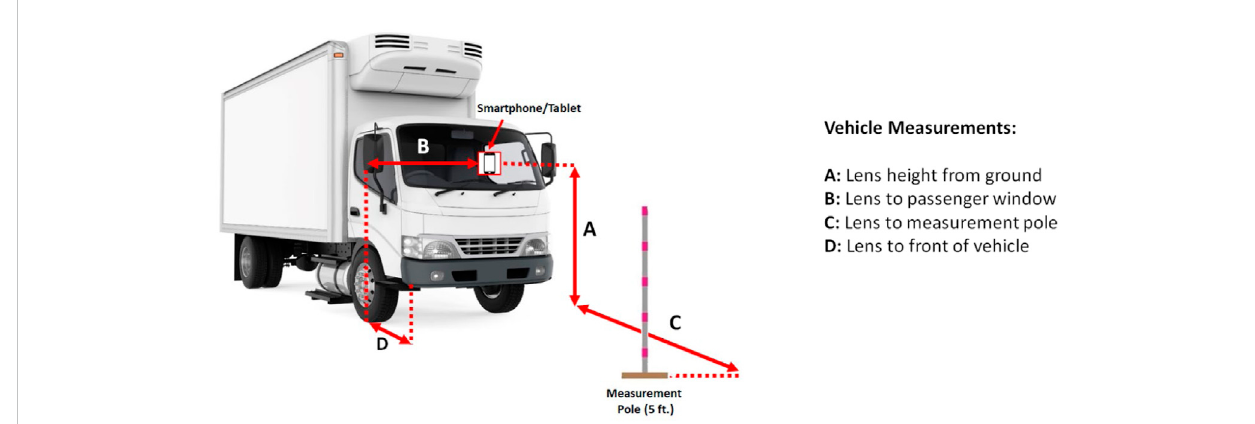
FIGURE 2 VIEWappmeasurement instructionsshowingtheplacementofthe fi ve-foot measurementpole,thesmartphoneortabletinthedriverseat,andthe four measurements. (The lens position is assumed to be the location of the cyclopean